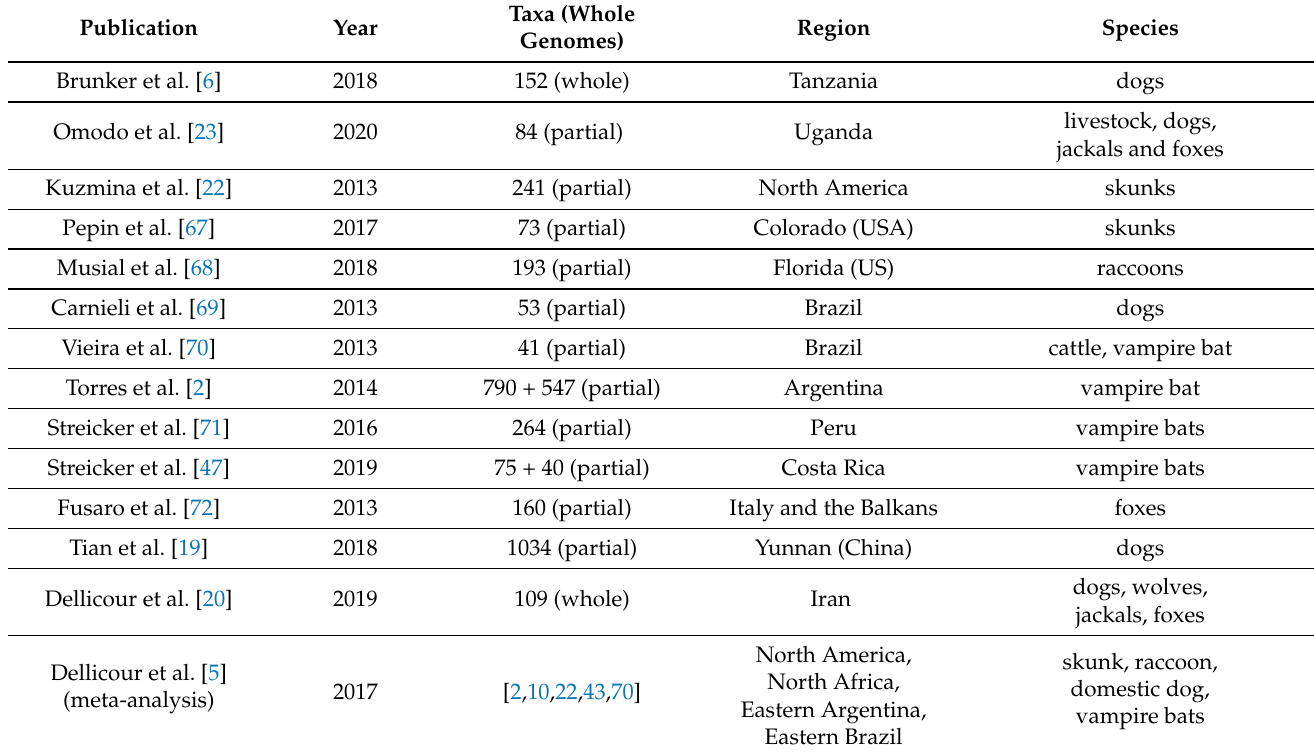
Table 2. Overview of continuous phylogeographic studies on RABV considered. As was the case for the discrete phylogeo- graphic studies, many analyses did not have whole-genome sequences at their